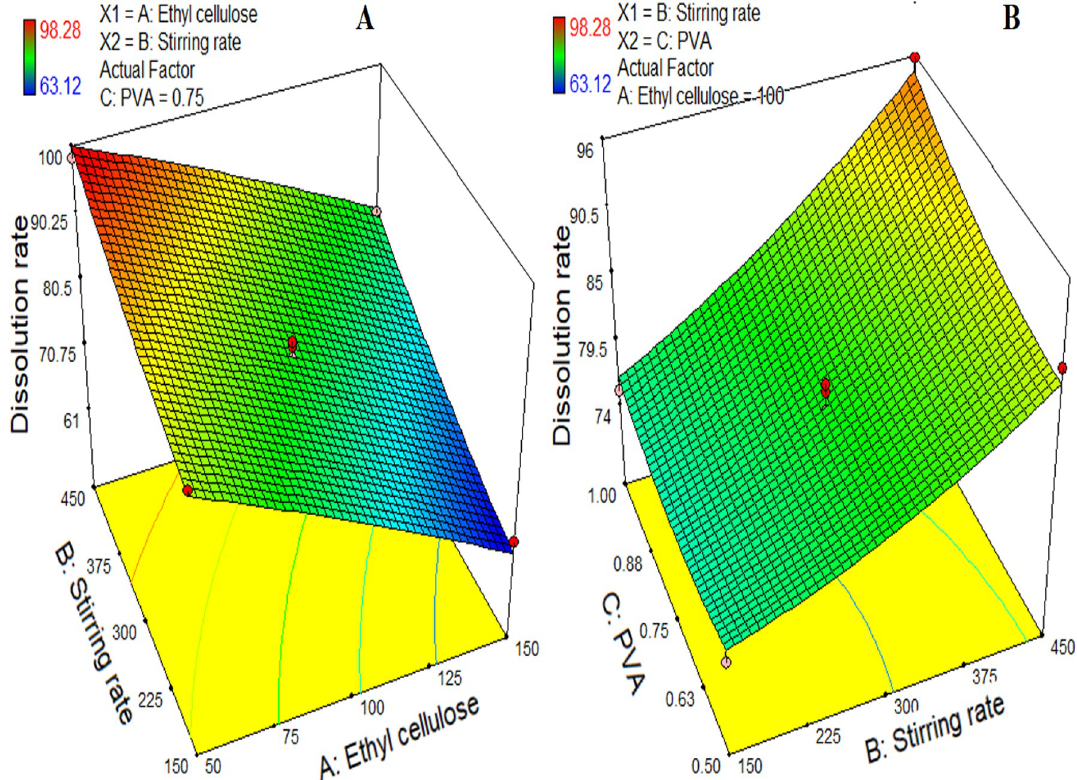
Fig 4. 3-dimensional response surface graphs indicating (A) the effect of the concentration of polymer and stirring speed on dissolution rate, and (B) the effect of the surfactant (PVA) concentration and stirring speed on dissolution rate.